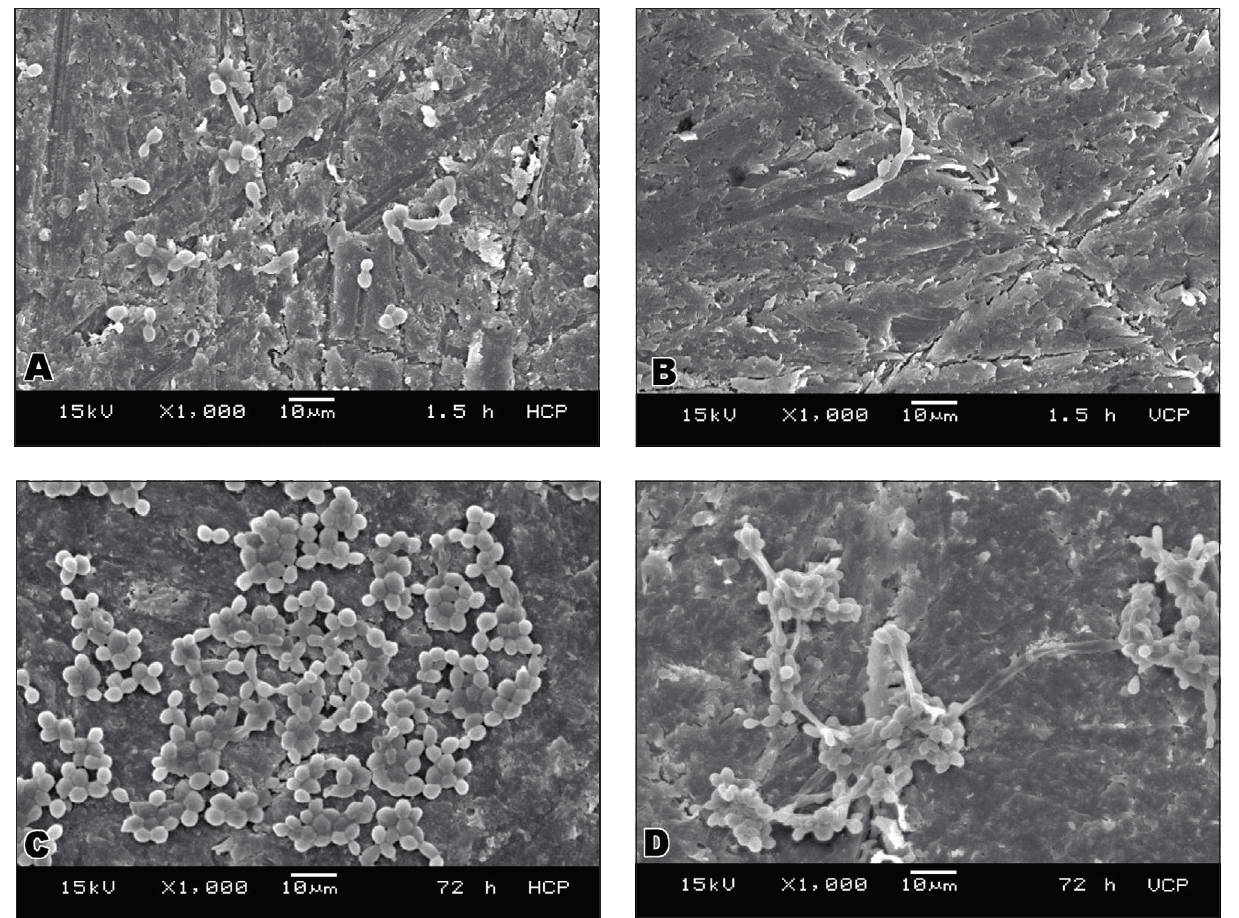
Figure 3 - SEM visualization of biofilm developed on the resin disk surfaces. ( A ) Disk placed in a horizontal or ( B ) vertical posi- tion, at the adhesion time point (1.5 hours). ( C ) Disk placed in a horizontal position or ( D ) vertical position, after 72 hours of biofilm